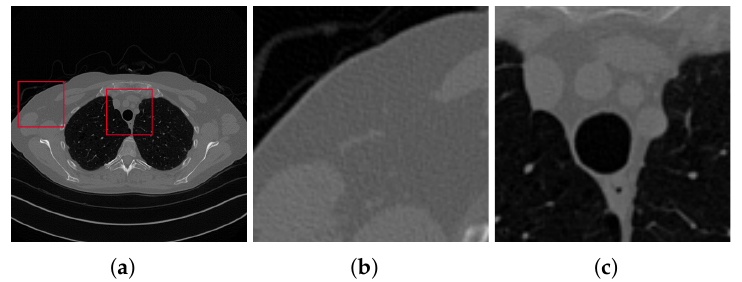
Figure 5. Ground truth image ( a ) and the two considered zooms-in ( b , c ), which are depicted by the red squares on the full image ( a